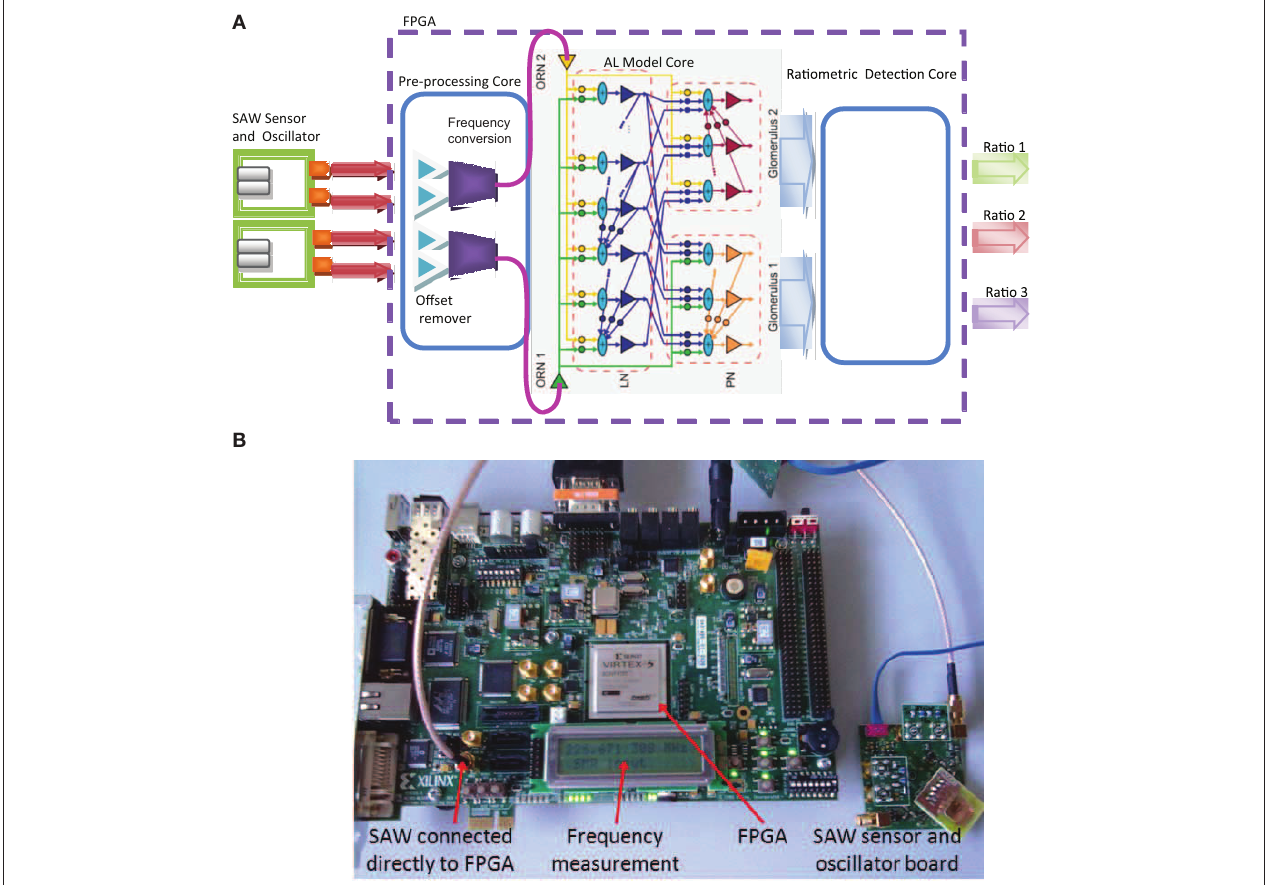
FIGURE 3 | (A) Neuromorphic MGC processor and its chemosensor array integration. The resonant oscillation frequency of the SAWR devices are measured in real − time by the FPGA through the pre − processing core that removes the common mode between reference and polymer − coated input signal channels (offset remover) and scales the chemosensor input signals linearly to drive the AL Model Core running